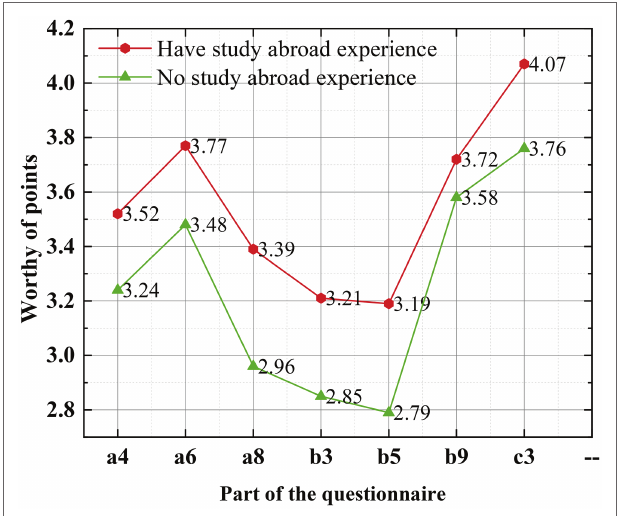
FIGURE 6 | Standard deviation of the scores of the questionnaire in the questionnaire